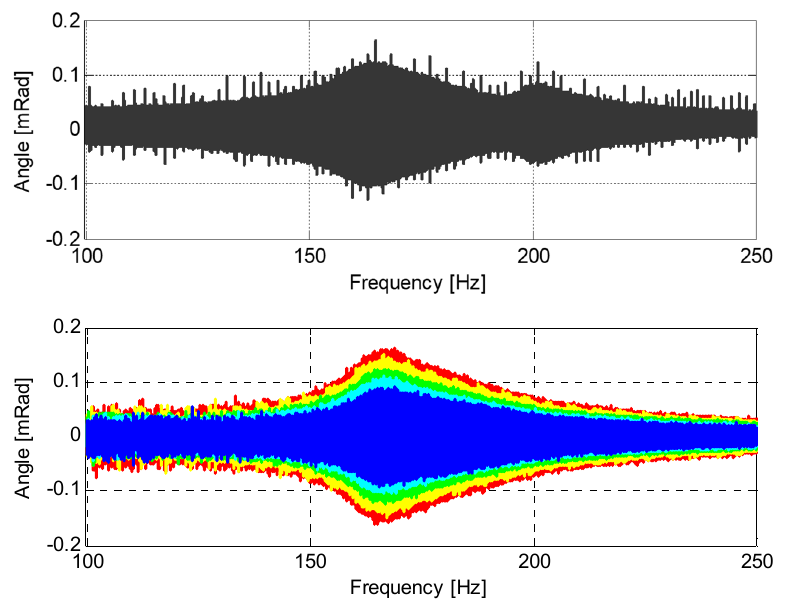
Figure 19. The results of RC testing. Standard RC test results are at the top; the results from the additional accelerometers are at the bottom. Material: saclSi 1; Isotropic pressure 50 kPa; Frequency spectrum 100–250 Hz; Excitation (torque) amplitude 0.5 V (– original built-in sensor, – the top sensor, S1, – the second sensor from the top, S2, – the third sensor from the top, S3, – the fourth sensor from the top, S4, – the bottom sensor, S5).